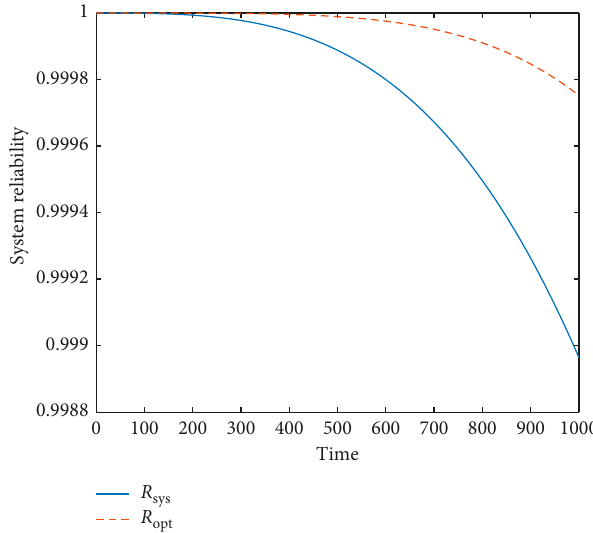
Figure 15: System reliability curves (Example 3). Table 18: Comparison of parameters before and after optimization (Example 3).